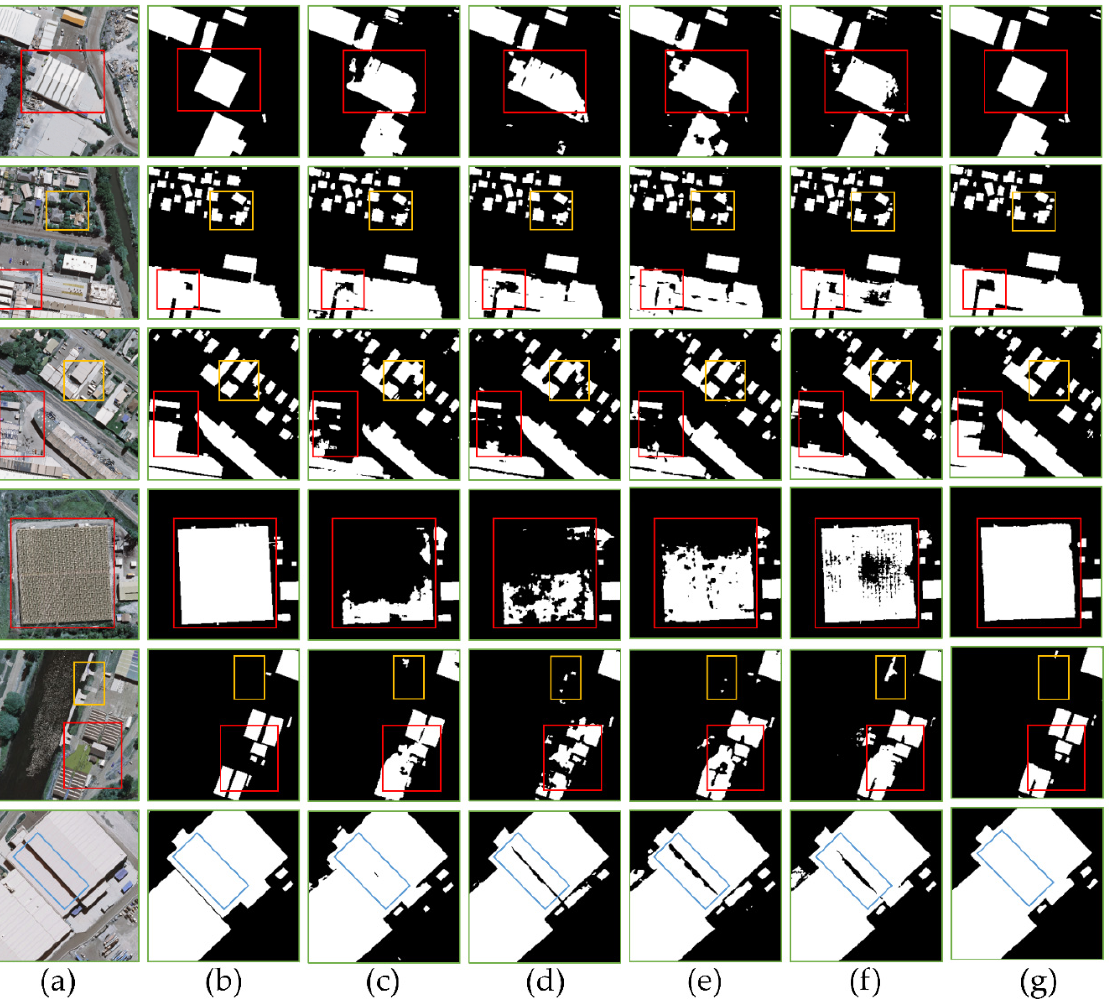
Figure 12. Extraction results of different models on the WHU Building Dataset. ( a ) Original image, ( b ) label, ( c ) U-Net, ( d ) Res-UNet, ( e ) LinkNet, ( f ) LinkNet*, ( g ) B-FGC-Net.